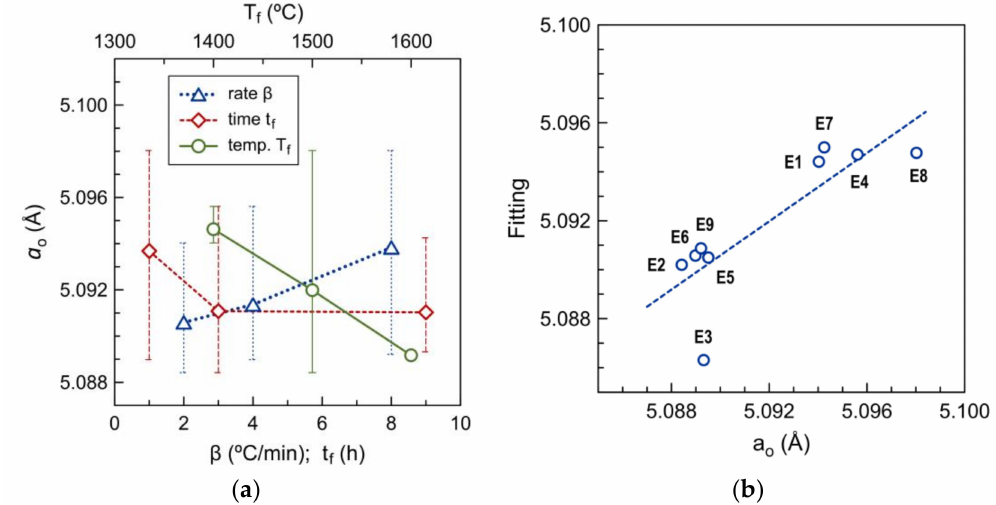
Figure 3. ( a ) Dependence of lattice parameter on heating / cooling rate, sintering temperature and time, based on averaged results from Table 1. Error bars show the lowest and highest results obtained at a given level of a specific factor; ( b ) Multivariate fitting vs. experimental results of lattice parameter (Equation